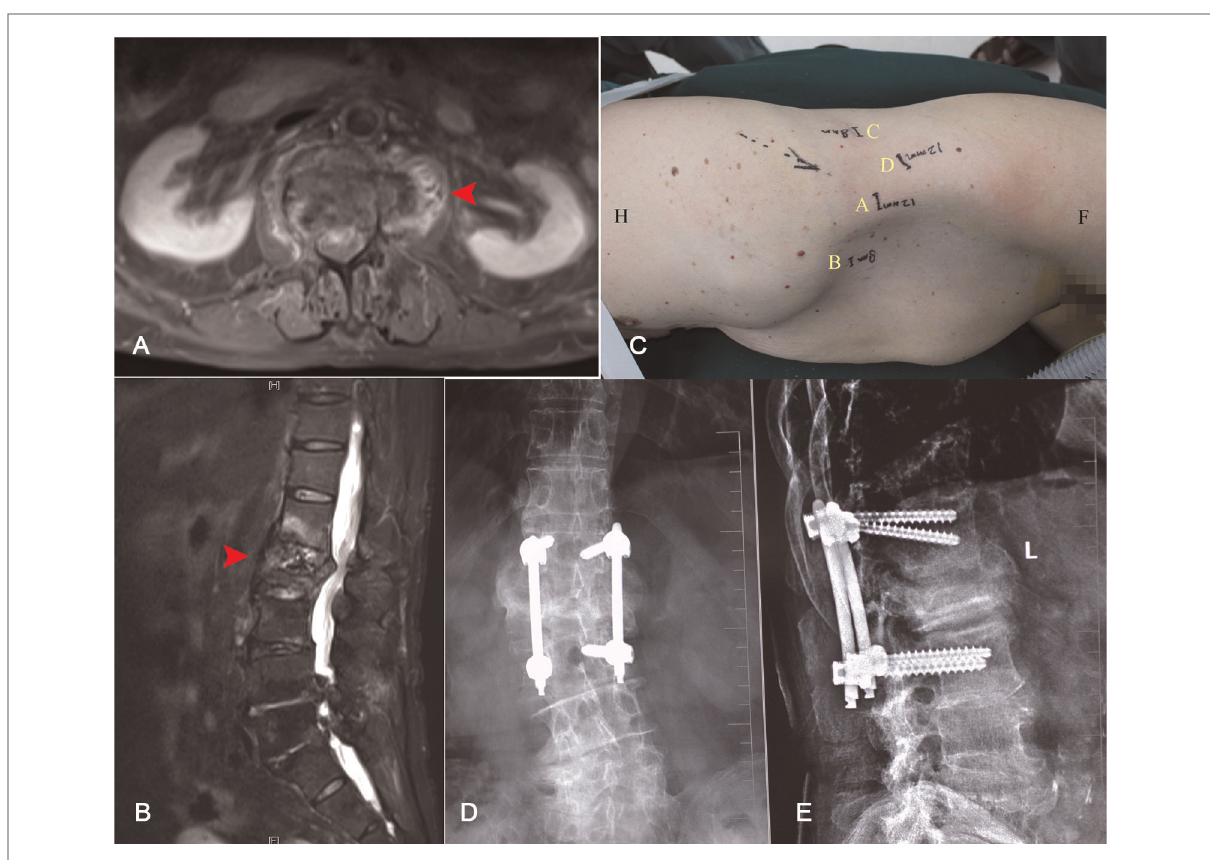
FIGURE 1 Cross section ( A ) and sagittal ( B ) T2-weighted MRI demonstrated destruction at the L1/2 intervertebral space and a partial L2 vertebral body (red arrow). The location of the working channel was planned before operation ( C ). Thirty months after the operation, the x-ray of the lumbar spine performed in the positive position ( D ) and the lateral position ( E ) showed the formation and fusion of the